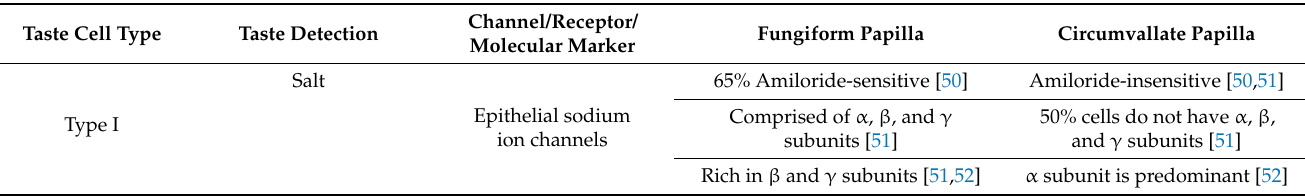
Table 1. Molecular components of taste bud cell types in fungiform and circumvallate papillae. Taste Cell